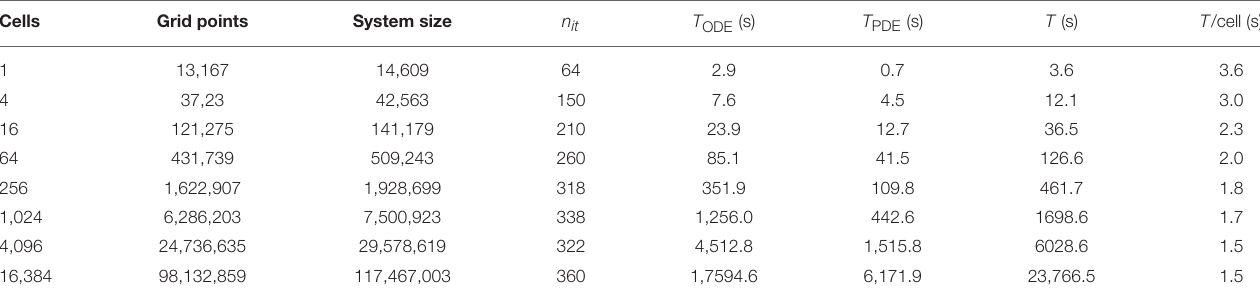
TABLE 8 | CPU times for the finite difference method using the Grandi membrane model for I ion . Cells